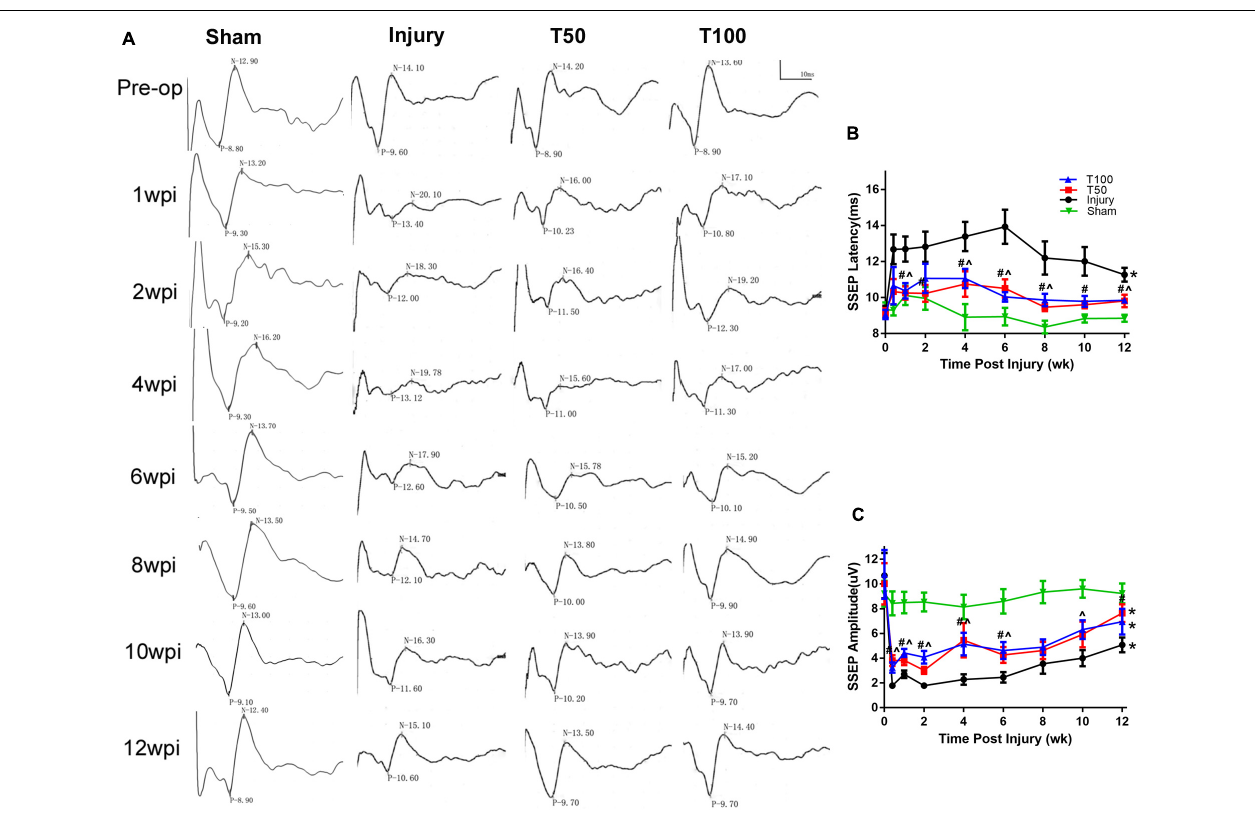
FIGURE 4 | Somatosensory evoked potential (SEPs) results. (A) SEPs waveform from preoperative to postoperative week 1, 2, 4, 6, 8, 10, and 12. (B) SEPs latency; (C) SEPs amplitude. * P < 0.05, comparison between each group and the sham group; # P < 0.05, comparison between T50 group and injury group; ∧ P < 0.05, comparison between T100 group and injury